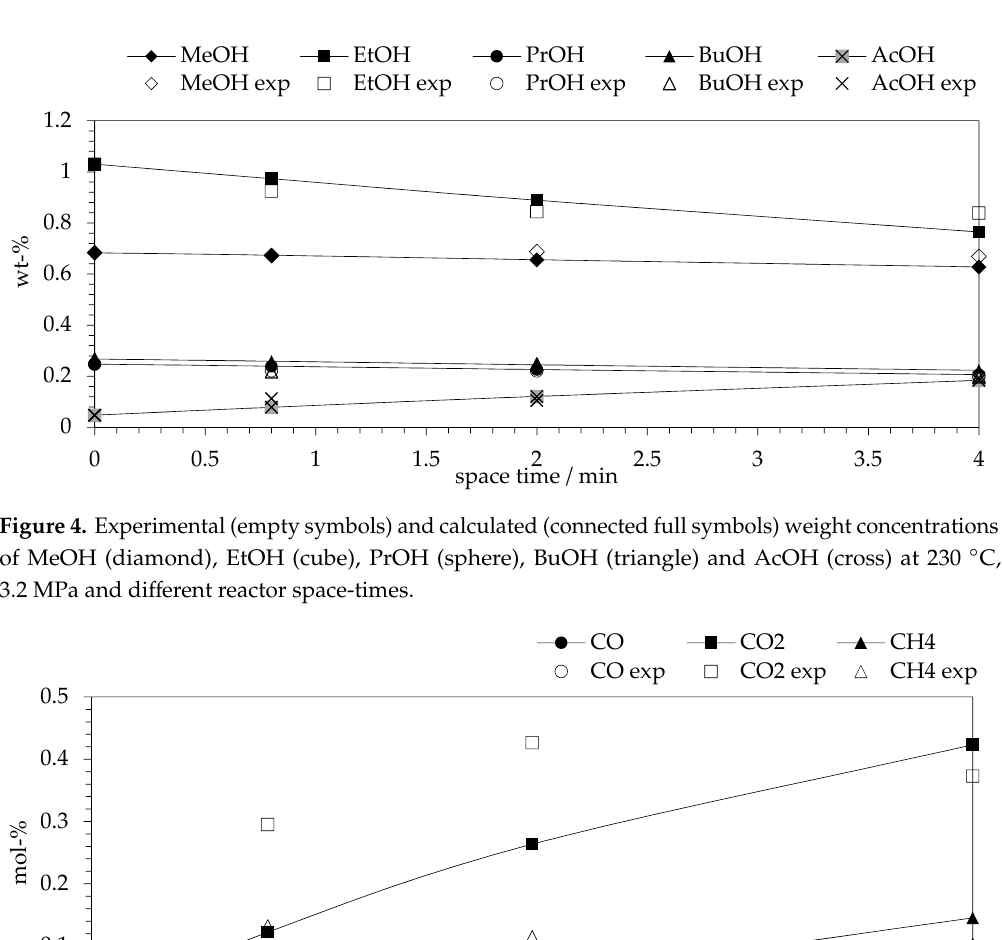
10 of 19 Figure 3. Parity plots of CO (empty triangles), CO 2 (empty cubes) and CH 4 (full spheres) concentrations. Examples of experimental and calculated liquid and gas phase concentrations as a function of space-time in the reactor are presented in Figures 4 and 5. Corresponding figures at other operating conditions of temperature and pressure are included in Appendix D (Figures S3–S12). In the mentioned figures, 0.8, 2 and 4 min correspond to 200, 80 and 40 h − 1 , respectively. In agreement with Figure 2, the fit of experimental and calculated liquid concentrations at different space-times (Figures 4 and S3–S7) elucidates the high accuracy of the model to estimate the composition of the outlet liquid stream. The experimental and model data obtained at 220 °C and 4.5 MPa exhibited the most accurate fit of the model (Figure S5). However, this data set did not include data at 4 min of space-time (as explained in Section 3.3), which might have been the cause of an apparent improved estimation. Generally, the model fit of PrOH, BuOH and AcOH was accurate at different operating conditions, whereas the estimation of MeOH and EtOH concentrations was slightly less successful. The fit of experimental and calculated gas concentration at different space-times (Figure 5 and Figures S8–S12) indicate some systematic deviations. The model typically underestimated